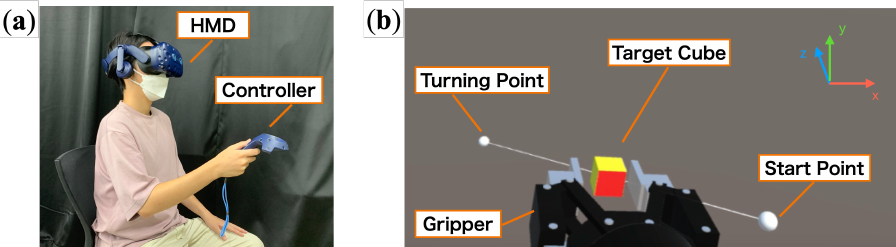
Figure 2. Experimental setup: ( a ) The operator wears the HMD while sitting on a chair and holds the controller in his right hand. ( b ) An image of the operator’s viewpoint displayed on the HMD.